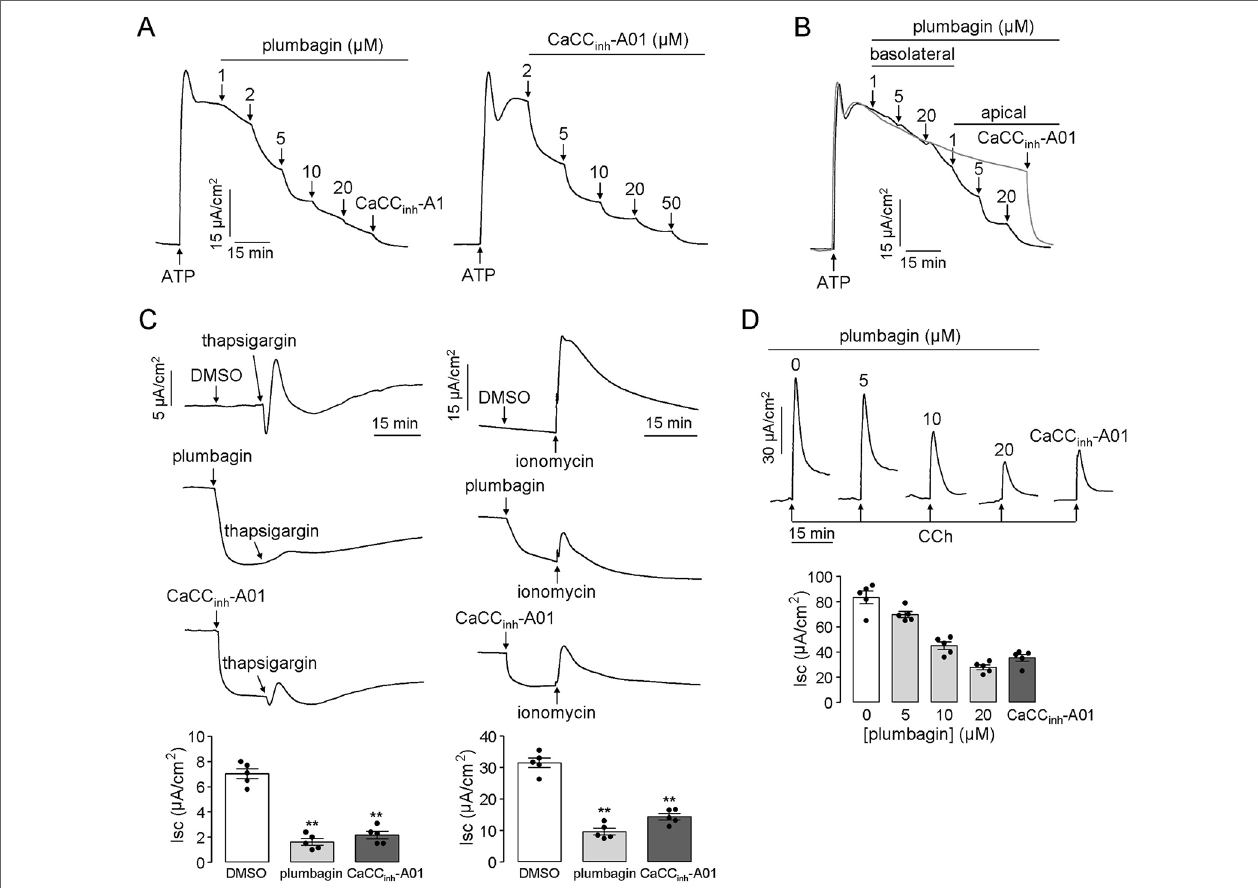
FIGURE 2 | Plumbagin inhibits the CaCC current in HT-29 cells and mouse colons. (A) Inhibitory effects of plumbagin on the short-circuit current induced by ATP (200 μM) in HT-29 cells. CaCC inh -A01 was set as the positive control. (B) Inhibition of the short-circuit current in HT-29 cells in which plumbagin was added first to the basolateral bathing solution and then to the apical bathing solution as indicated, following stimulation with 200 μM ATP. (C) Short-circuit current in HT-29 cells showing inhibition of the thapsigargin (1 μM)- or ionomycin (1 μM)-stimulated short-circuit currents by 15 min pretreatment with plumbagin (20 μM) (n = 4). “**” indicate significantly different from the DMSO at the P < 0.01 level. (D) Representative traces showing inhibition of the CCh (500 μM)-stimulated short-circuit current in mouse colons by 20 min pretreatment with the indicated concentrations of plumbagin or CaCC inh -A01 (100 μM) (n =